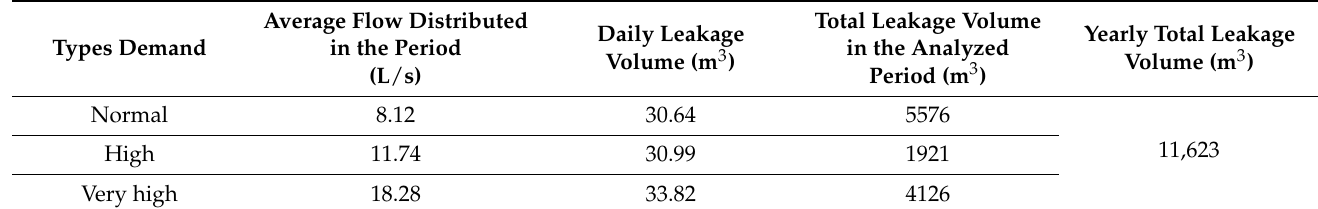
Table 2. Measured flow rates and simulated leakage values for different consumption